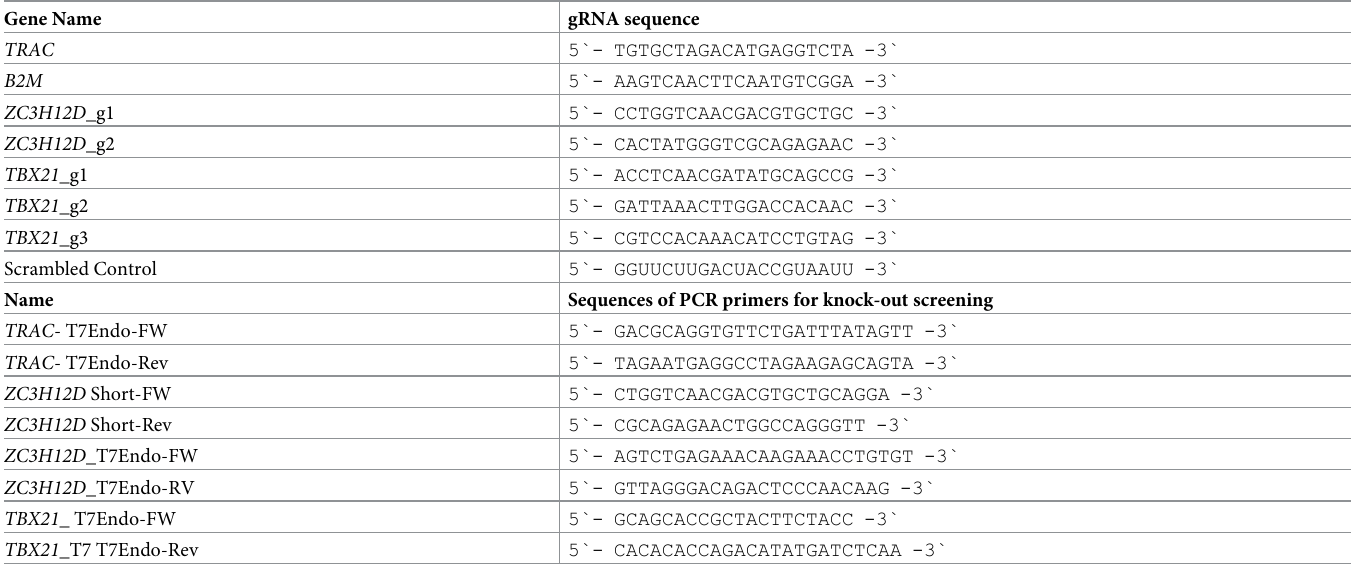
Table 1. Sequence of gRNA oligonucleotides and PCR